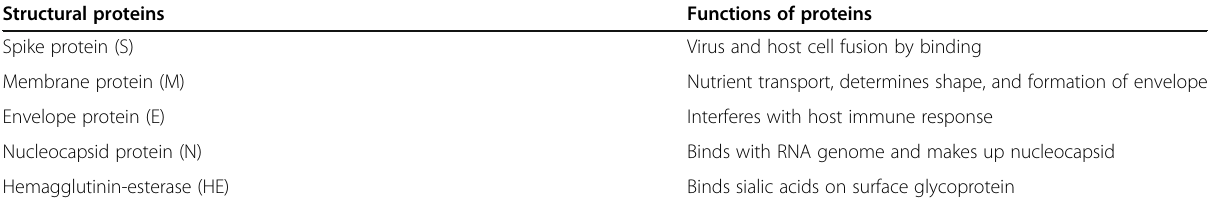
Table 3 Structural proteins of coronavirus and their functions Structural proteins